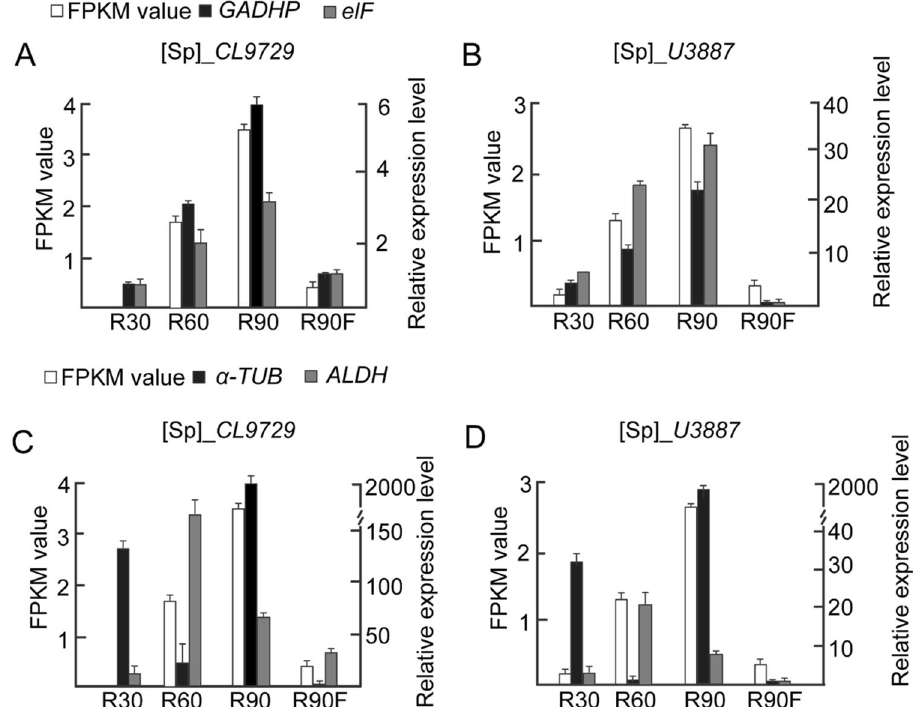
Figure 4. Validation of identified candidate reference genes as internal controls for normalizations of target genes of CL9729 and U3887 . Two stable reference genes of GAPDH and elF (A, B) and two unstable reference genes of ALDH and α-TUB (C, D) were used as internal controls to detect the expression levels of CL9729 and U3887 during different rhizosheath development stages. R30, R60, R90, and R90F indicate the tissues of 30-,